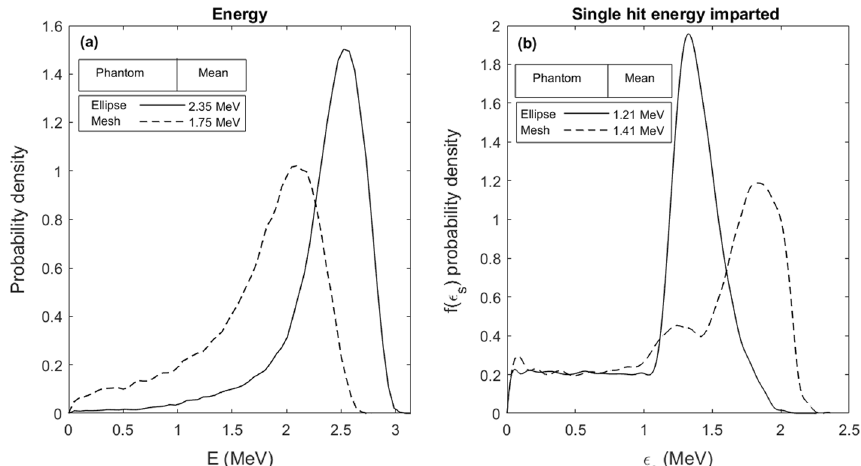
Fig. 6 Simulated energy ( a ), and energy imparted ( b ) PDFs per alpha particle hitting any of the cell nuclei volumes in the elliptical cylinder phantom or the mesh volume phantom,